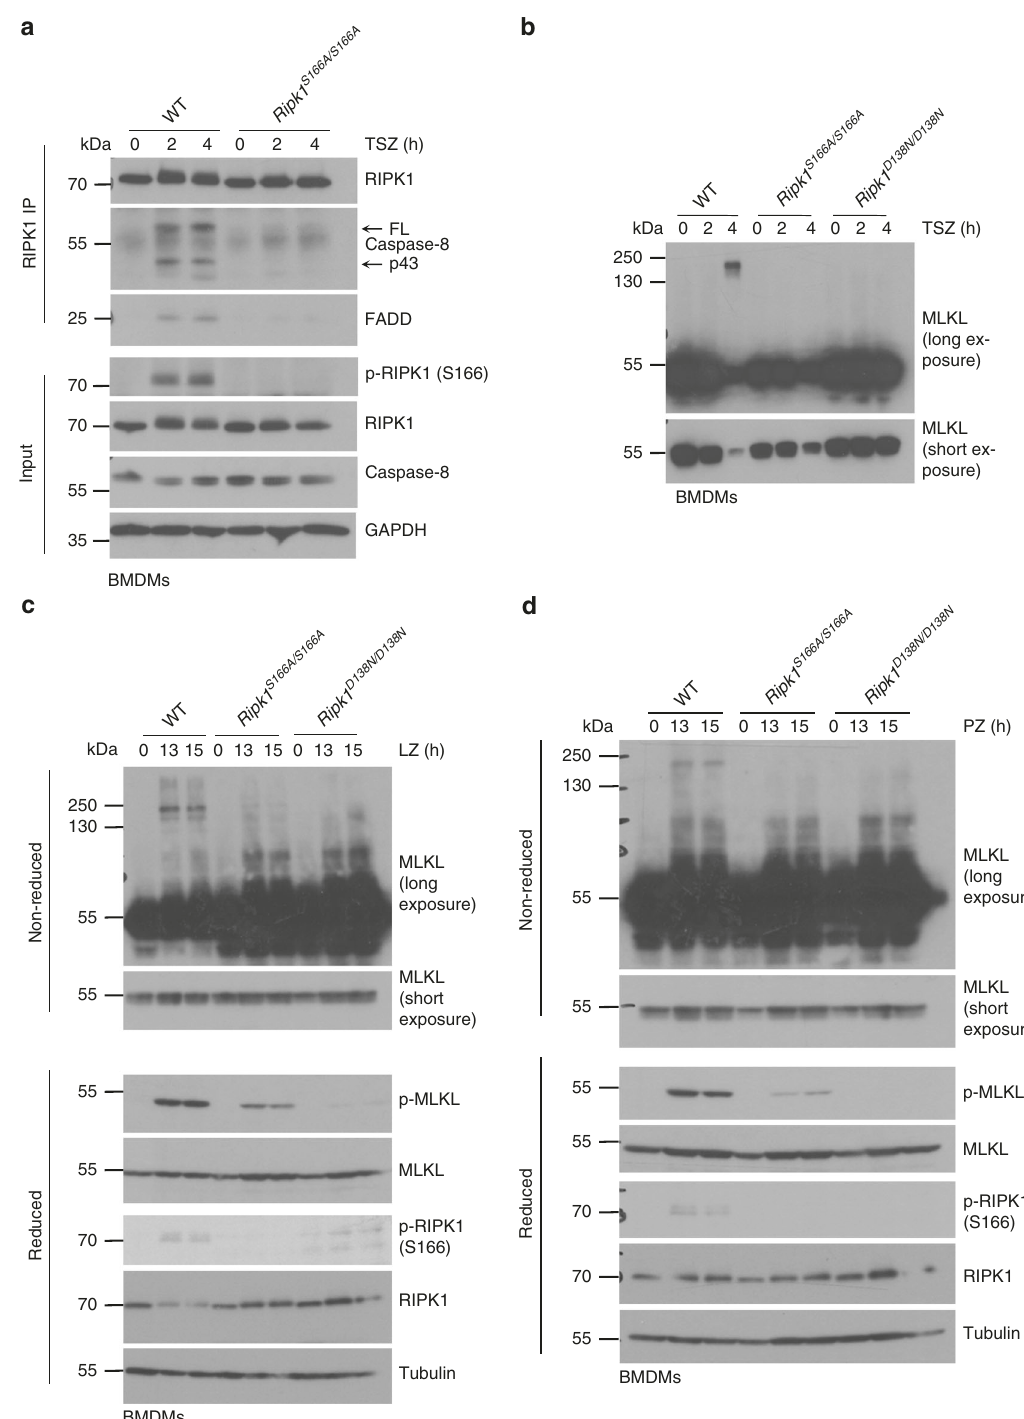
Fig. 2 S166 phosphorylation facilitates necrosome formation. a BMDMs from mice of the indicated genotypes were treated with TNF (T; 10 ng ml − 1 ), SMAC mimetic (S (Birinapant); 1 µ M) and Z-VAD-FMK (Z) for 0, 2 and 4 h. RIPK1 immunoprecipitates and total cell lysates (input) were analyzed by immunoblotting with the indicated antibodies. b BMDMs from mice of the indicated genotypes were treated with TNF (T; 10 ng ml − 1 ), SMAC mimetic (S (Birinapant); 1 µ M) and Z-VAD-FMK (Z) for 2 and 4 h. Lysates were processed under non-reducing conditions and analyzed for presence of MLKL by immunoblot. c BMDMs from mice of the indicated genotypes were treated with LPS (L; 100 ng ml − 1 ) and Z- VAD-FMK (Z) for 13 and 15 h. Lysates were processed under non-reducing or reducing conditions and analyzed by immunoblot using the indicated antibodies. d BMDMs from mice of the indicated genotypes were treated with Poly(I:C) (P; 0.5 μ g ml − 1 ) and Z-VAD-FMK (Z) for 13 and 15 h. Lysates were processed under non-reducing or reducing conditions and analyzed by immunoblot using the indicated antibodies. a , c Representative data of three independent experiments is shown. b , d Representative data of two independent experiments is